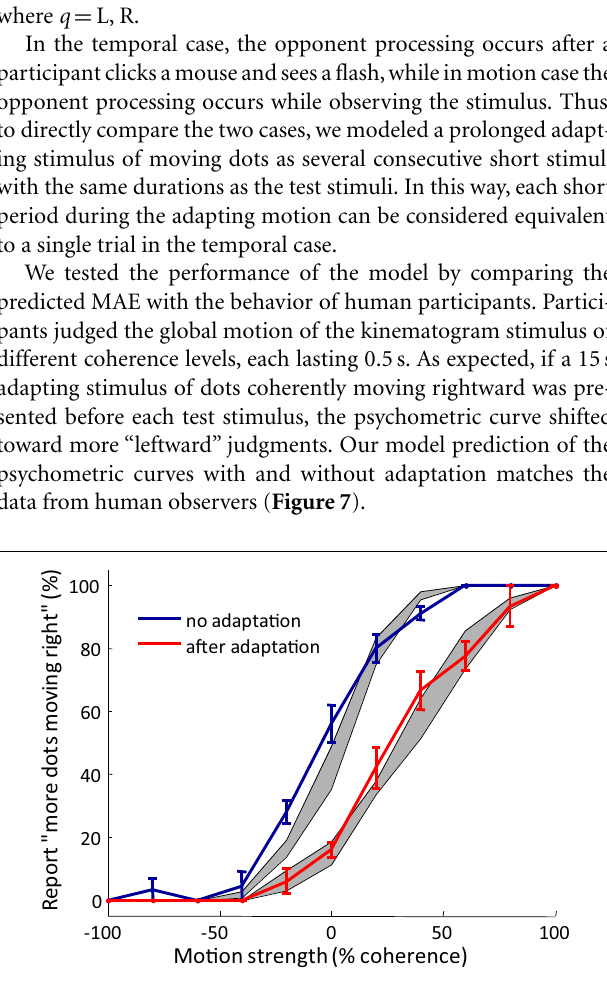
FIGURE 7 |Typical psychometric curves showing motion aftereffect, as tested with random dot kinematograms. Solid lines: psychometric curves averaged over participants ( n =5). Error bar=SEM Red curve: adaptation condition in which participants view 15s of dots moving rightward before each test stimulus of varying coherence that lasts 0.5s. Blue curve: control condition in which there is no adapting stimulus preceding the test stimulus. Grey areas: simulation result from the model in Relation of the model to motion direction judgments (mean ± SEM).